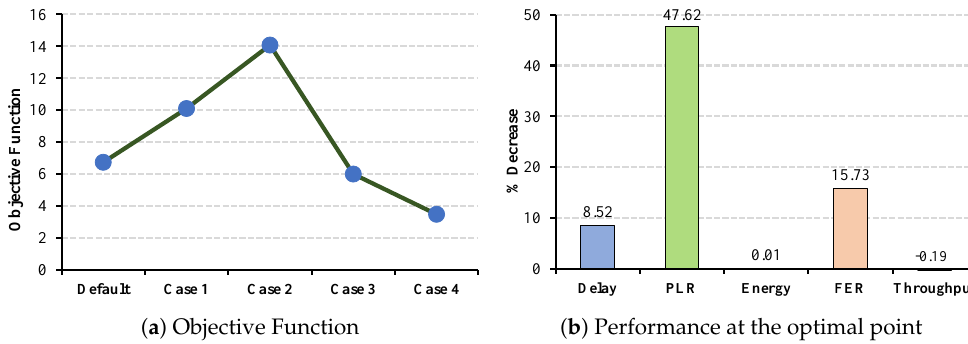
Figure 11. ECG QoS metrics and energy consumption under CW changes for all